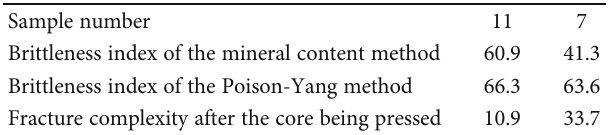
Table 4: Comparison of brittleness index and fracture complexity after the rock being